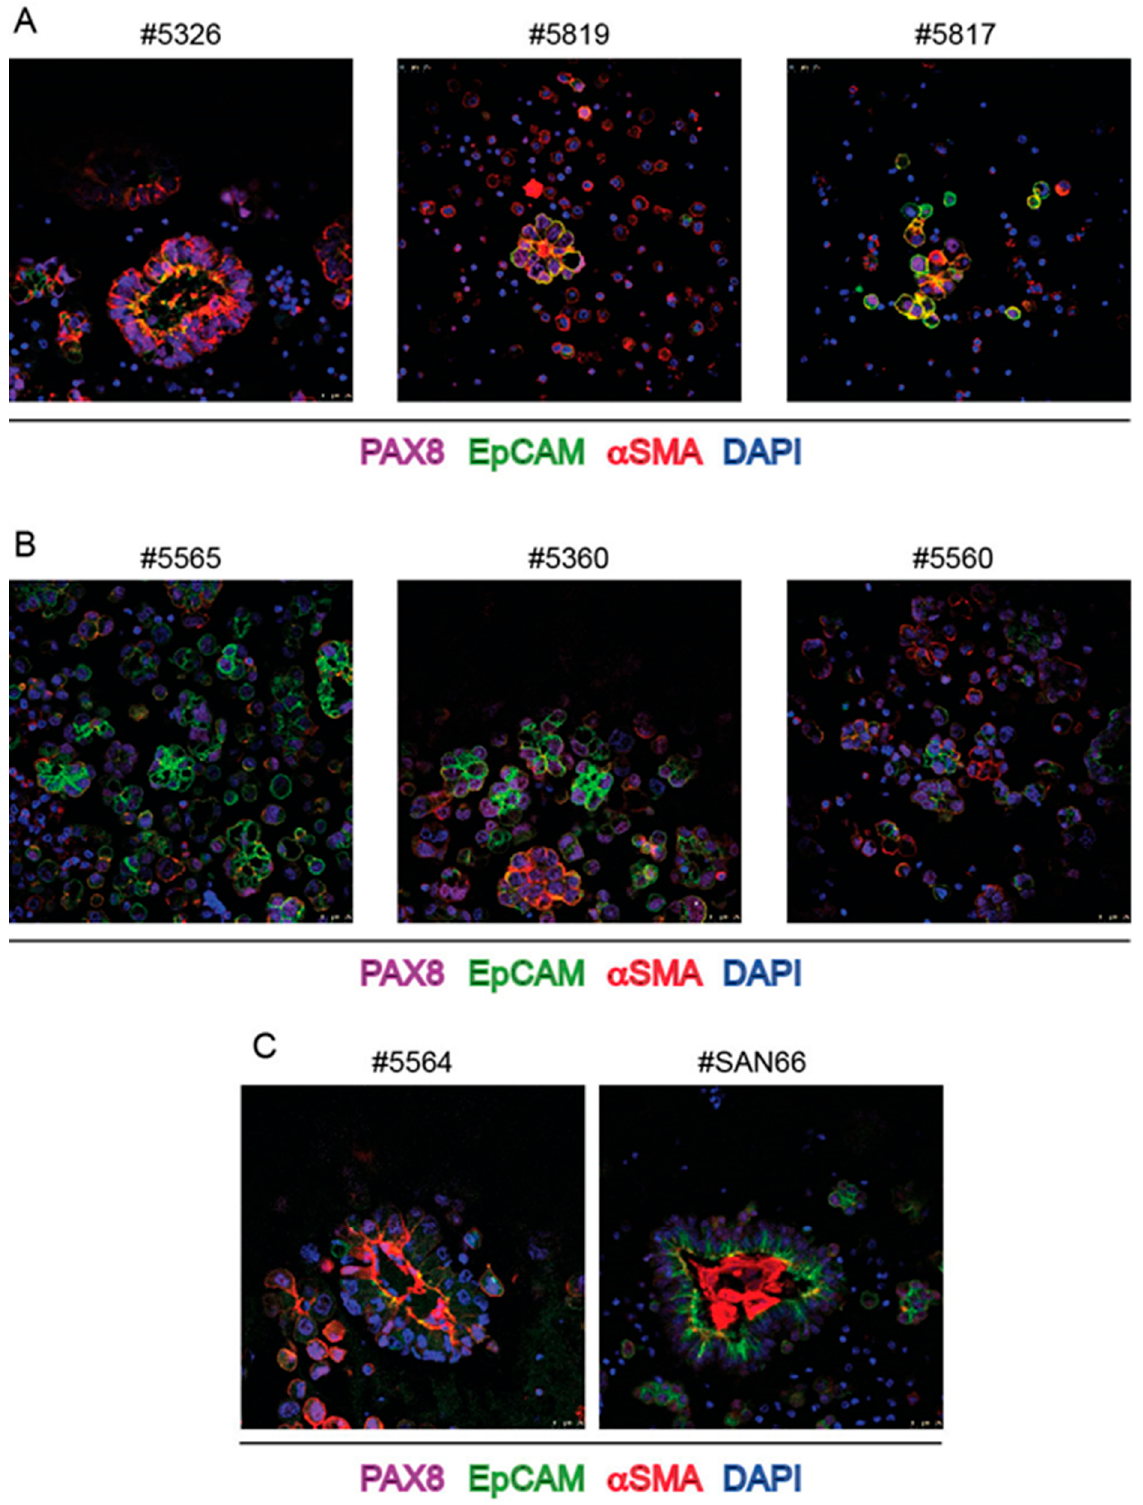
Figure 5. IF staining of spheroids from bulk ascites samples with PAX8, EpCAM and α SMA MAbs and DAPI ( A ): three independent cases; ( B ) three successive withdrawals of ascites of the same patient; ( C ): two independent cases stained with PAX8, EpCAM and α SMA MAbs to show staining of a few α SMA positive cells with PAX8 negative nuclei. Numbers on top of each panel correspond to the Profiling protocol numbers of the collected ascites. Details of each #case are in Supplementary Table S1.